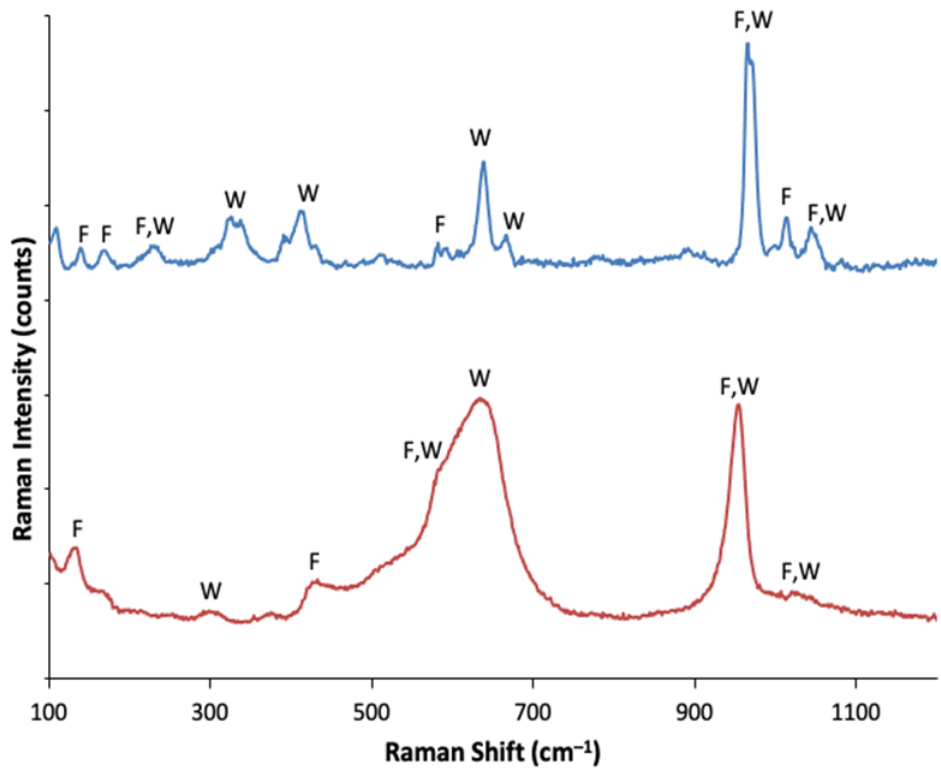
Figure 4. Raman spectra of the Mn-doped bioactive glass-ceramic as obtained after treatment at 700 °C (red line, below) and at 1100 °C (blue line, above). Table 3. Raman bands of the Mn-doped bioactive glass-ceramic after treatment at 700 and 1100 °C.